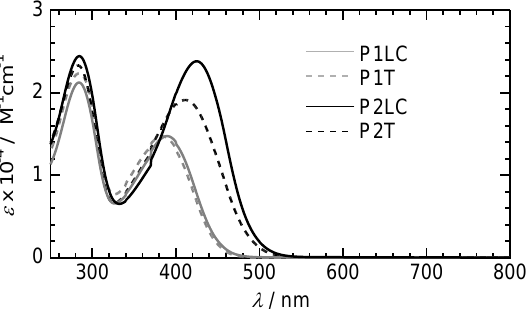
Figure 2. UV-vis absorption spectra for P1LC (gray solid line), P1T (gray dashed line), P2LC (black solid line), and P2T (black dashed line) in chloroform solutions ( c = 5 × 10 −5